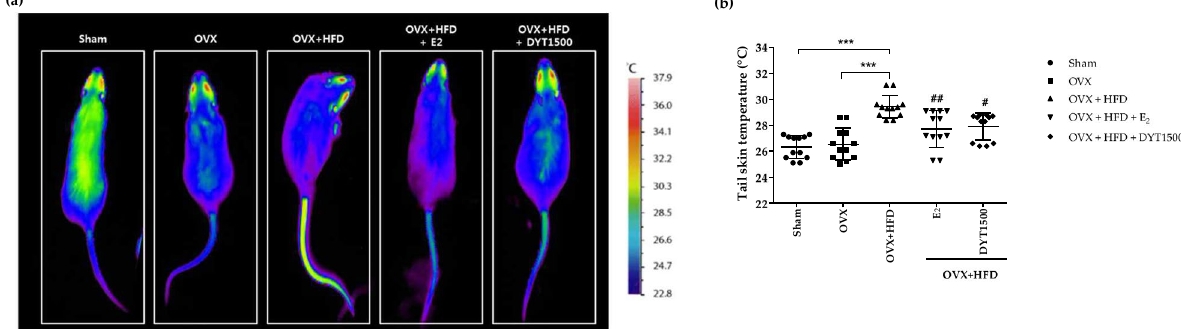
Fig. 7 Effect of DYT on the tail‑ or body‑ temperature. Tail skin and infrared body temperatures were evaluated with an infrared thermometer or thermography, respectively ( a ), and data of tail‑skin temperature was analyzed using software PRISM (Graphpad; CA, USA) ( b ). Data are presented as mean SD (n 7). *** p < 0.001 vs. Sham group or OVX group. # p < 0.05, ## p < 0.01 vs. OVX ± =